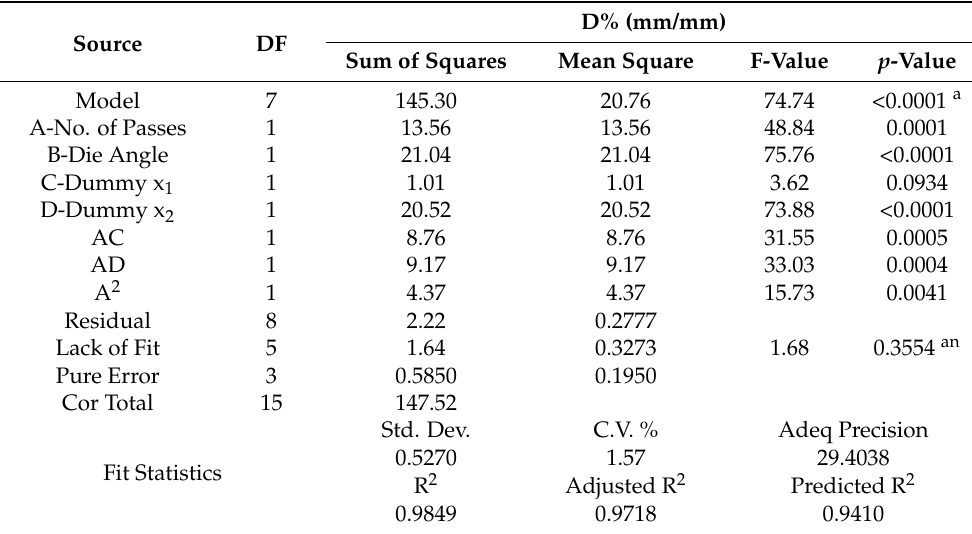
Table A5. Analysis of variance of D% percentage of